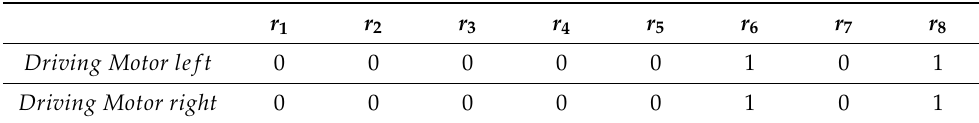
Figure 15. Symptoms changing trend when driving motor fails at 104 s. Table 3. Fault–symptom relationships r 1 to r 8 for condition monitoring of actuators of the driving system (case